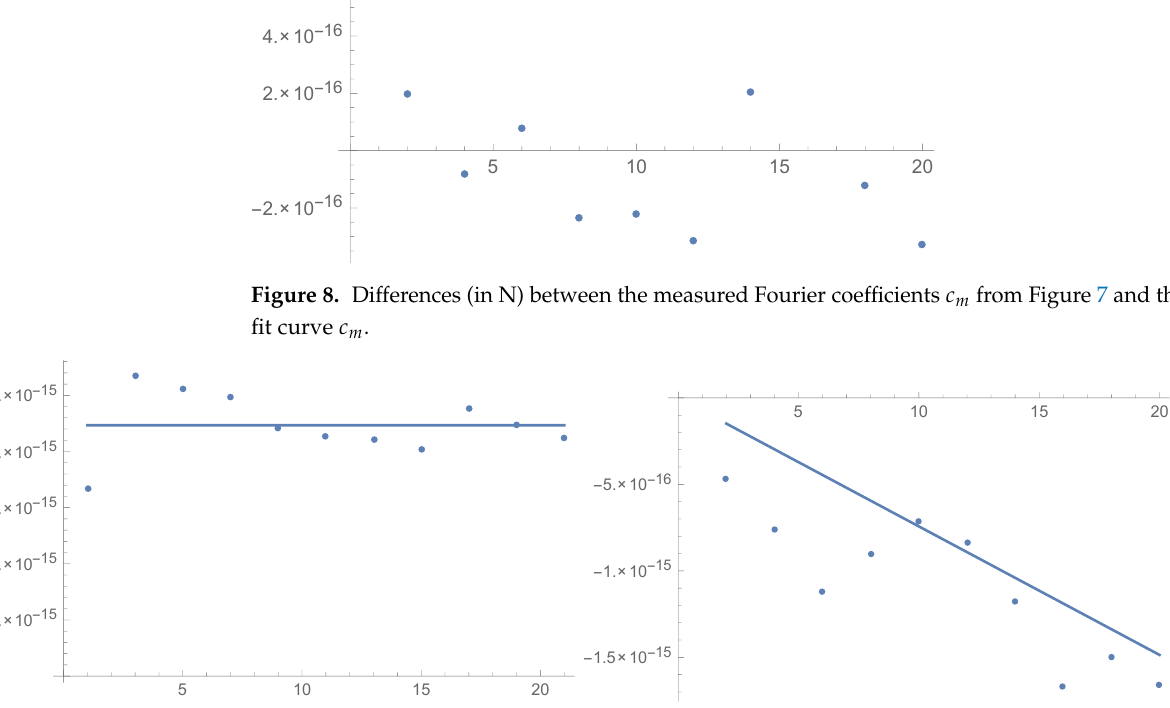
Figure 9. Fourier coefficients in N at z = 200 nm ( left ) c m for cosines with odd m = 1,3,5, . . . , where the line is the best constant fit, and ( right ) b m for sines with even m = 2,4,6, . . . , where the solid line is obtained using (24) with previously determined δ and f ( 0 )